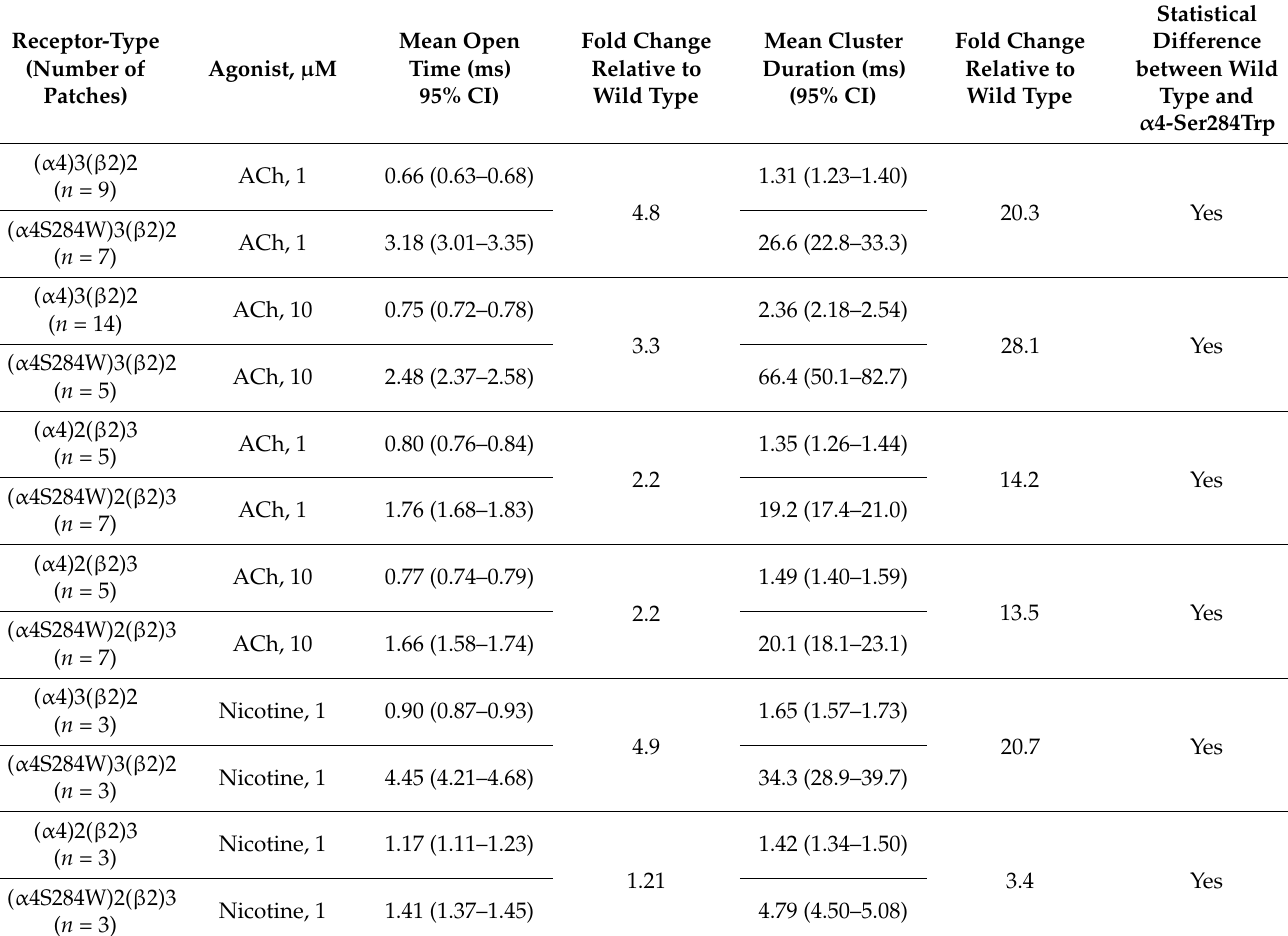
Table 1. Effect of α 4Ser284Trp on mean open time and mean cluster duration.